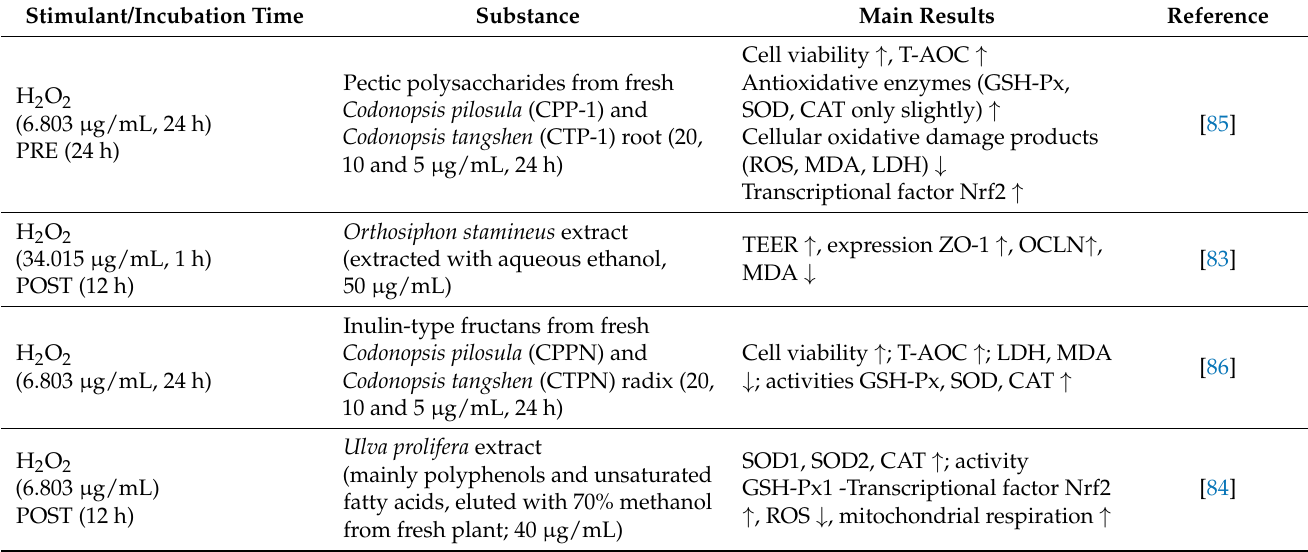
Table 4. Anti-oxidative effects of PFA on IPEC-J2 cells.